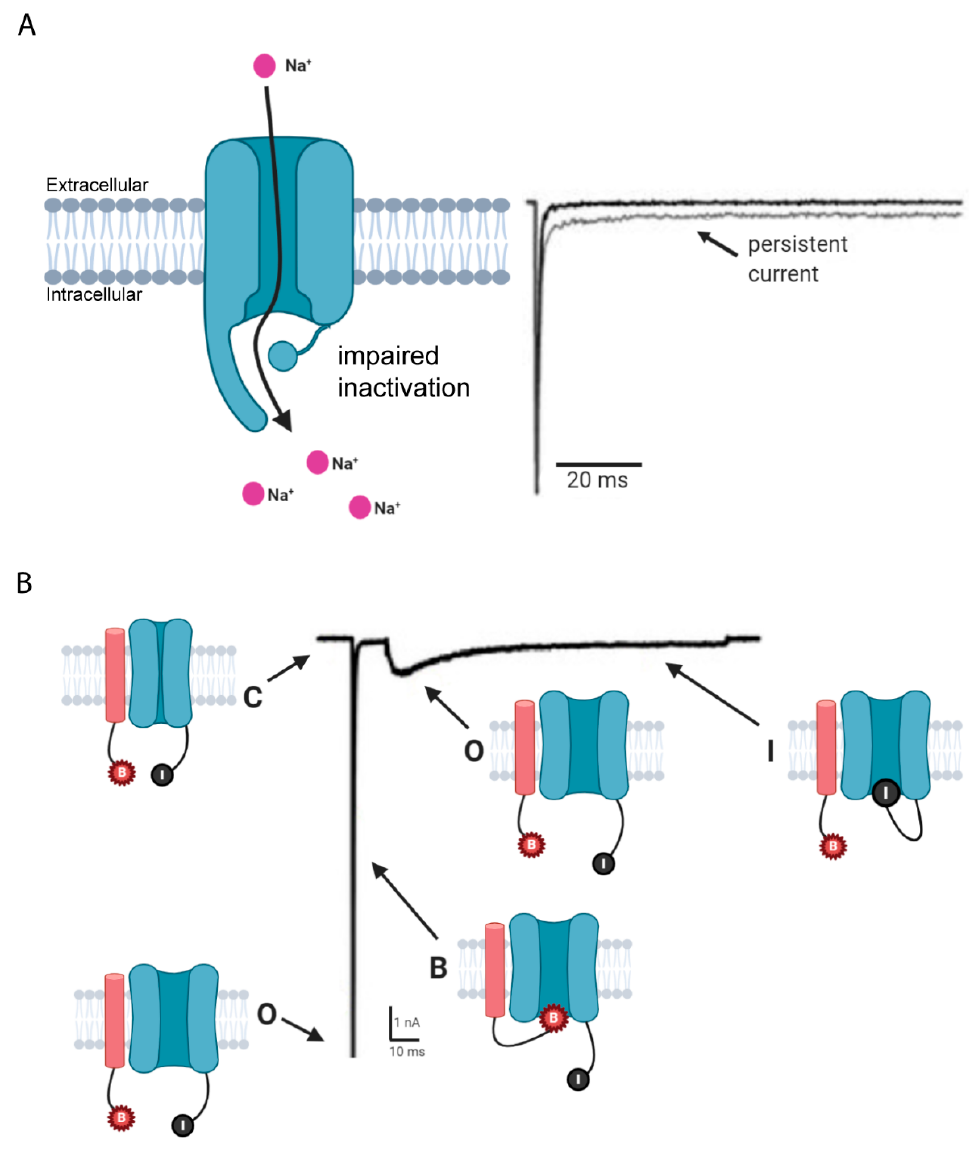
Figure 3. Persistent and resurgent sodium currents. ( A ) Schematic of persistent sodium current traversing the channel due to incomplete, or impaired, inactivation. ( B ) Resurgent sodium current schematic of channel conformations that have undergone open channel block (B, blocking particle; I, inactivation particle). C, closed. O, open. B, block. I, inactivated. Figure was created with BioRender.com.